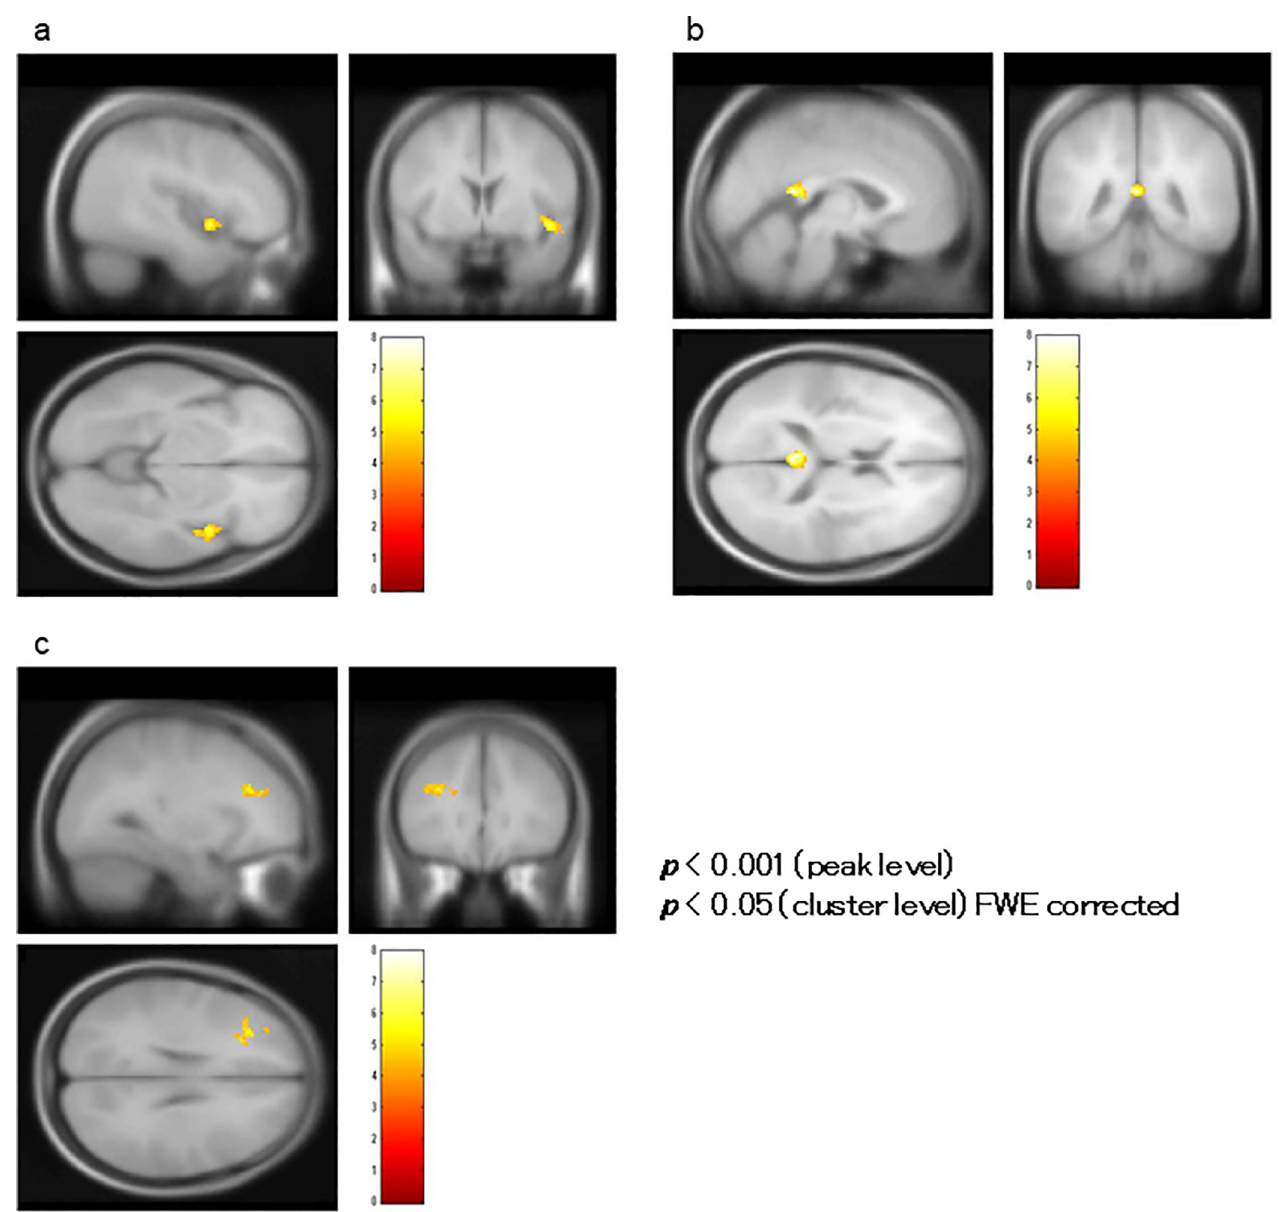
Fig 11. Correlation analysis of BOLD signal changes in the right Heschl’s Gyrus (HSC). (a) Blood oxygenation level-dependent (BOLD) activity in the right insula, (b) left posterior cingulate, and (c) left middle frontal gyrus significantly correlated with that of the right HSC of patients.